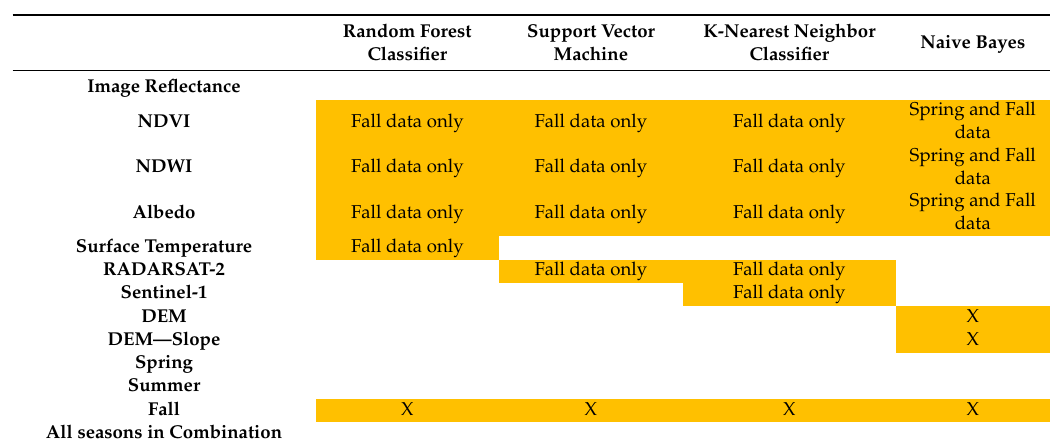
Summary of the lowest performing input feature combinations for individual classification